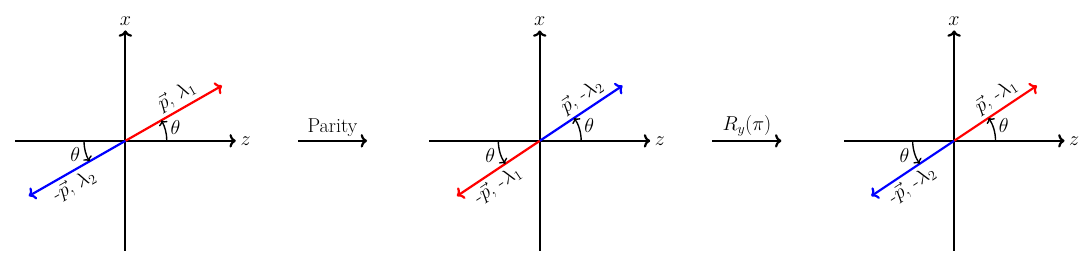
Figure 7 . The geometric picture behind (B.14) and (B.20). Particle 1 is red and particle 2 is